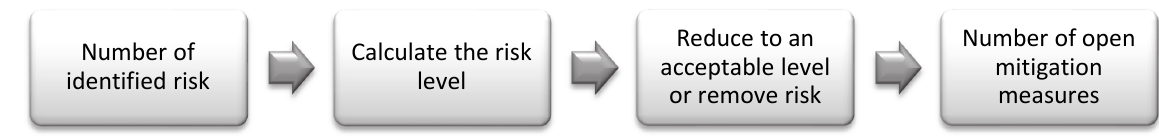
Fig. 4. RMPM process steps of